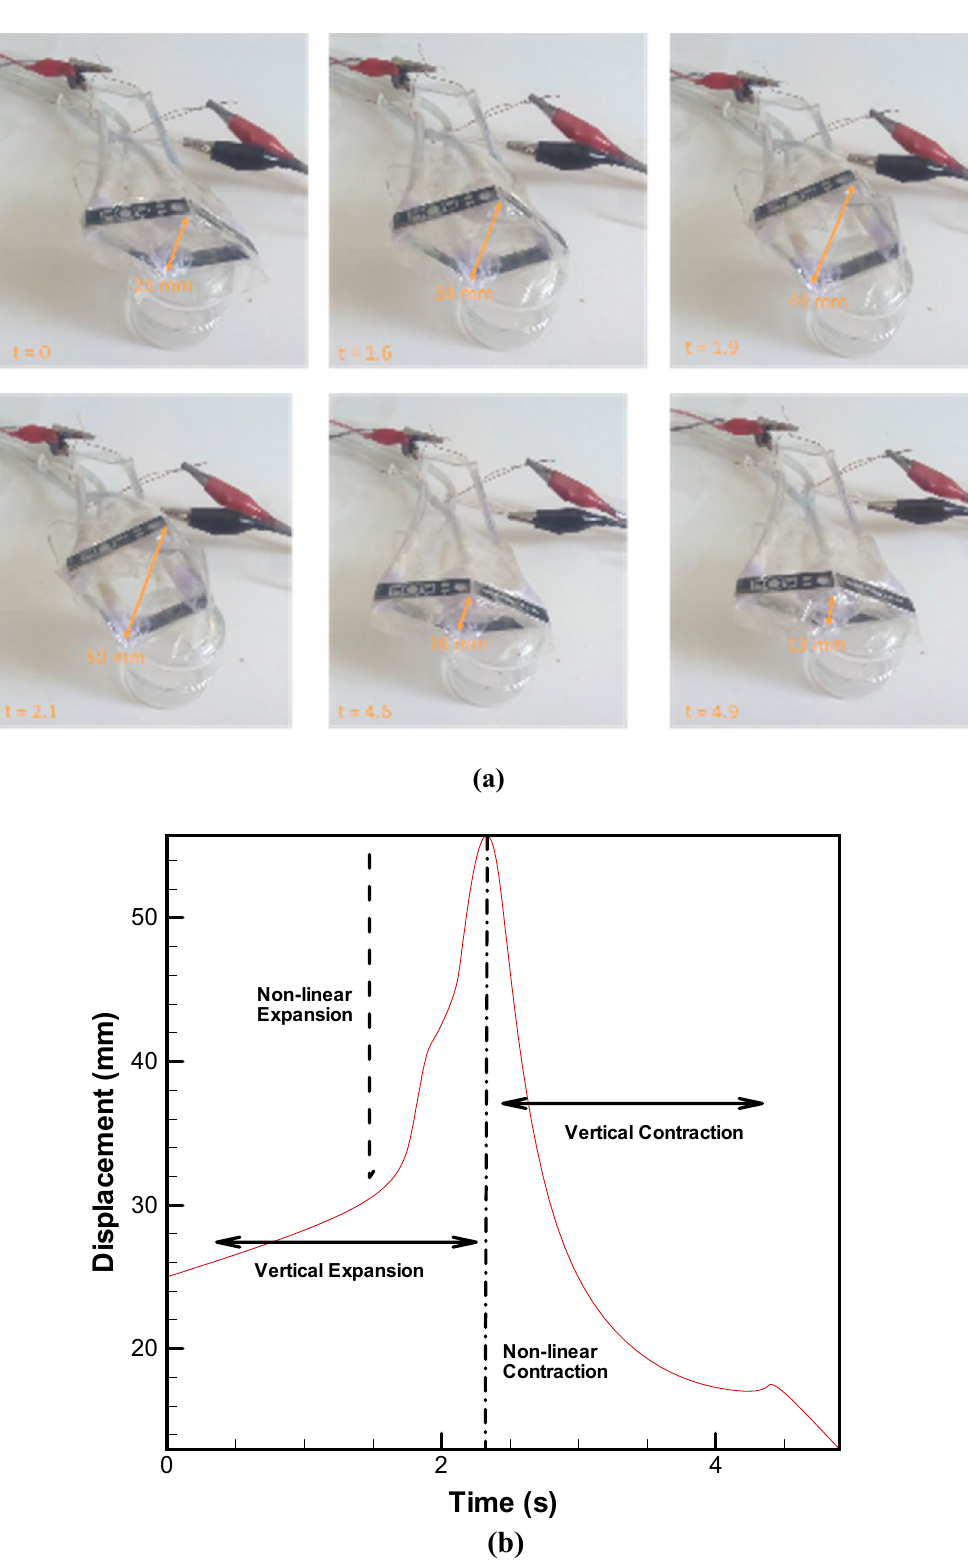
Figure 6. Displacement of set of soft skin-solid structure over time. Vertical and horizontal displacement of a set of soft skin-solid structure using HEFR technique (a) . Plot of vertical displacement (thickness of airfoil skeleton) over time (b)